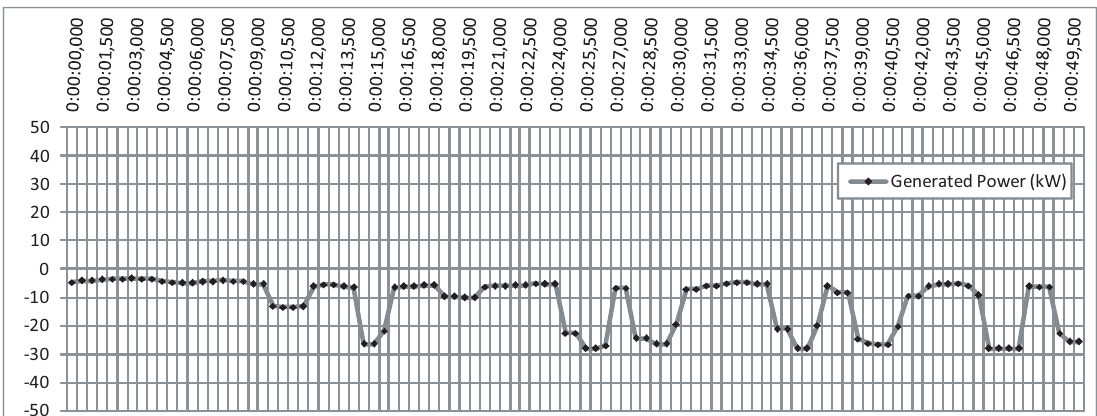
Figure 24. Generated power measured at the NEREIDA wave power plant of